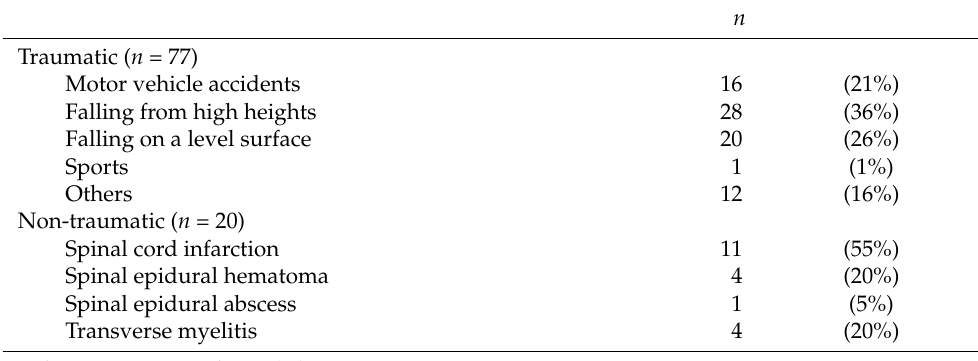
Table 1. Etiology of spinal cord